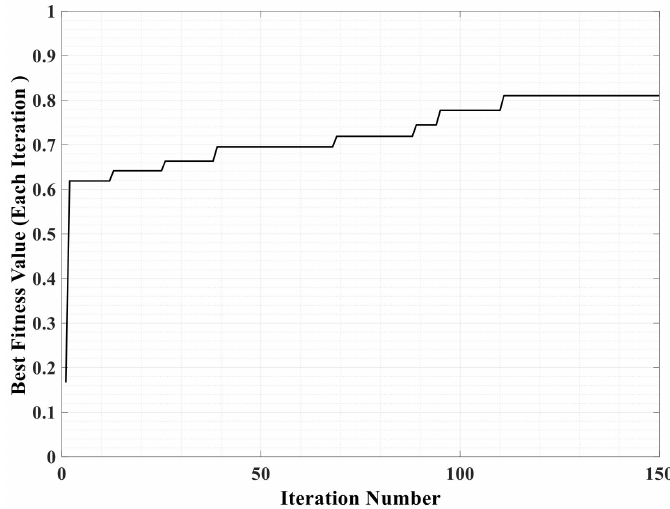
Figure 9. Fitness convergence curve.